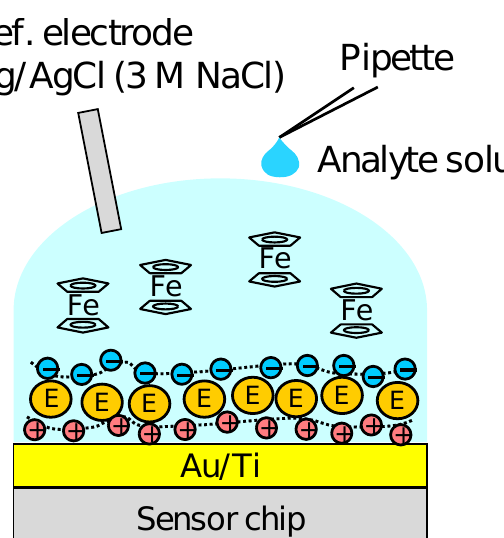
Figure 2. Schematic illustration of setup for H 2 O 2 and Glu